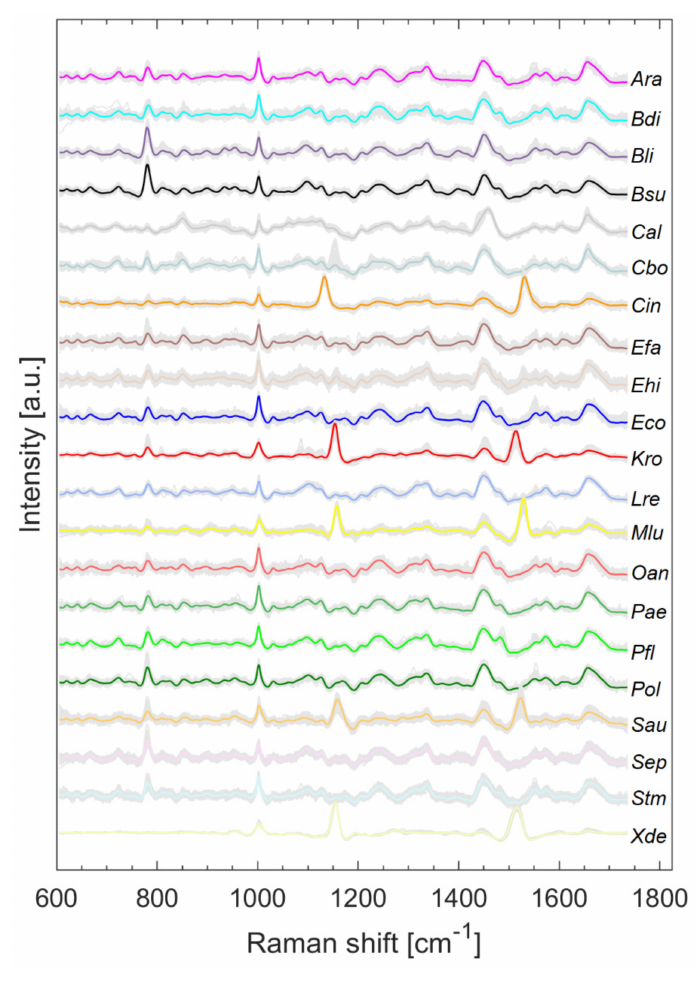
Figure 2. Raman spectra collected from microorganisms on the silver mirror slide after baseline correction, smoothing, and normalization with arithmetic means highlighted in